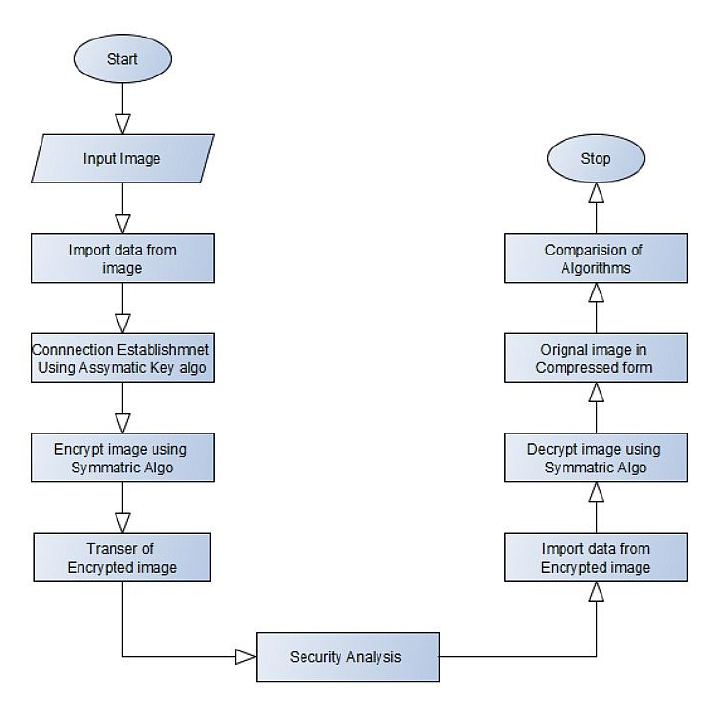
Figure 2. Flow chart for image encryption and decryption.